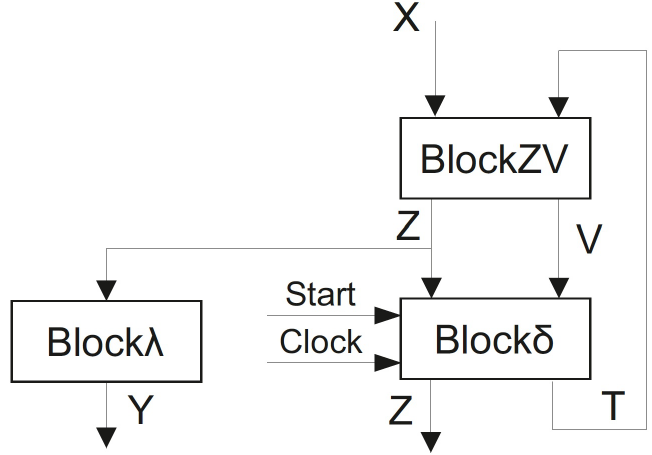
Figure 4. Architecture of Mealy FSM U 3